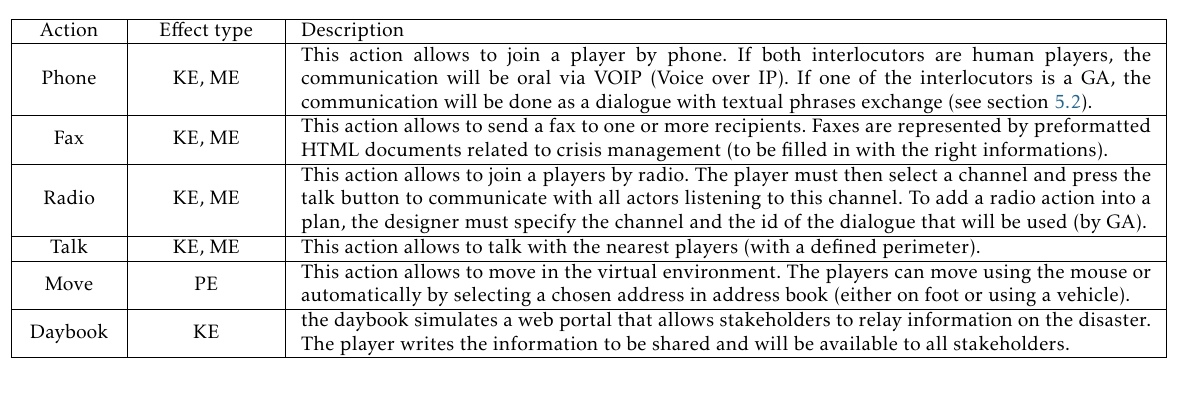
Table 1. Example of Crisis Management Actions and their effects.